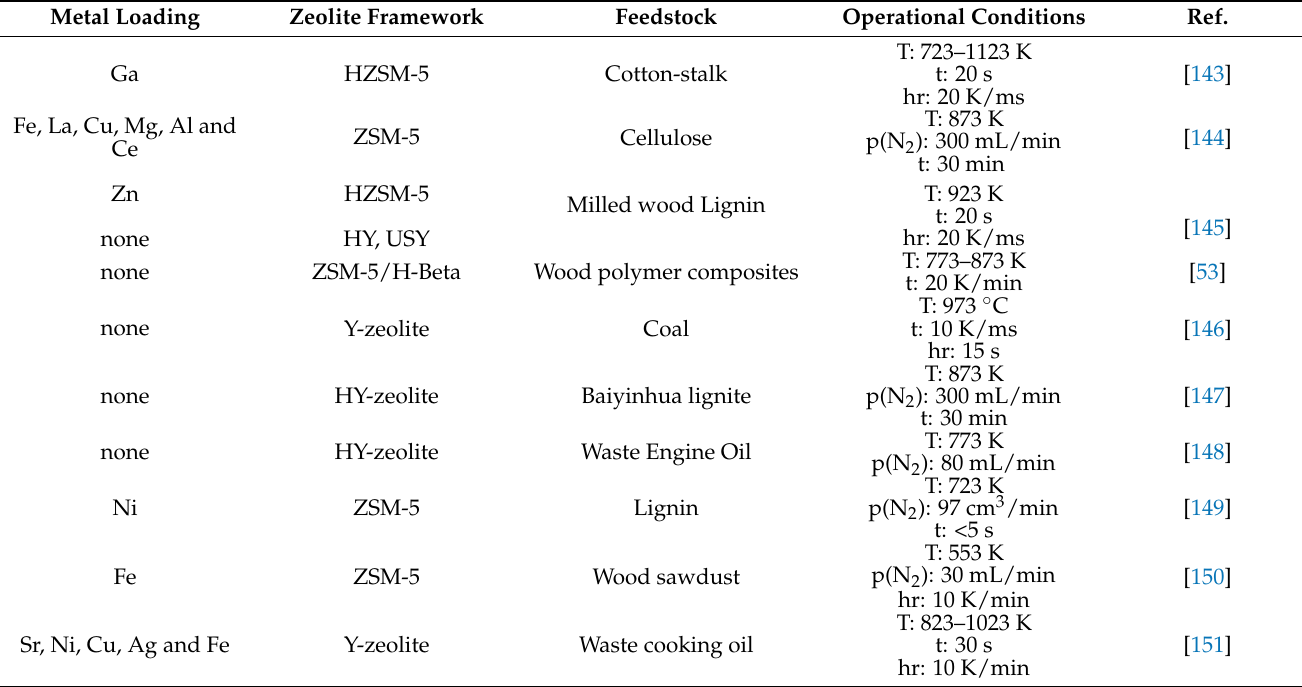
Table 3. Several metal loadings zeolites used in catalytic fast pyrolysis. Zeolite Framework Feedstock Operational Conditions